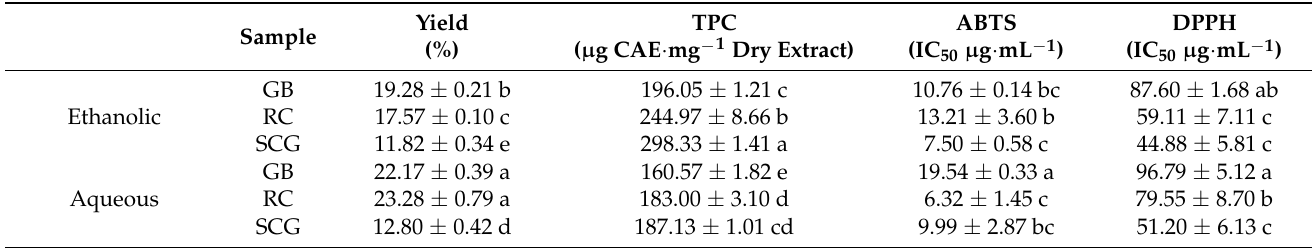
Table 1. Total phenols and the antiradical scavenging activity of coffee